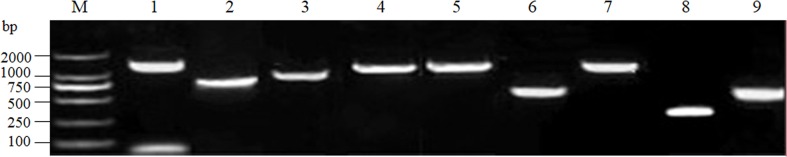
The amplification of each fragment of SY01 by RT-PCR.M represents the DL2000 marker, 1–9 represent the nine fragments of SY01.